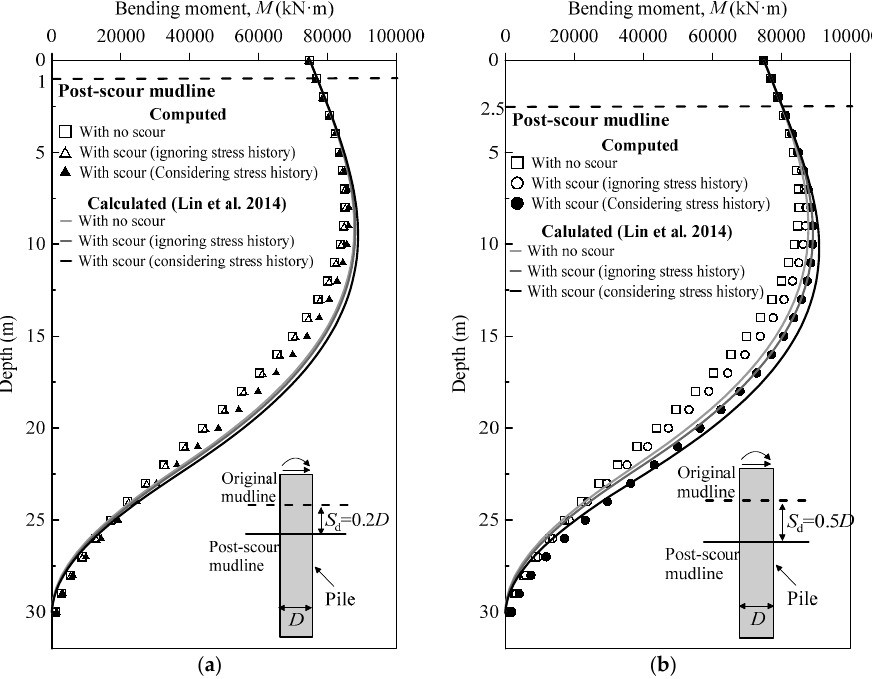
= 0.2 D ; ( b ) S = 0.5 D d d